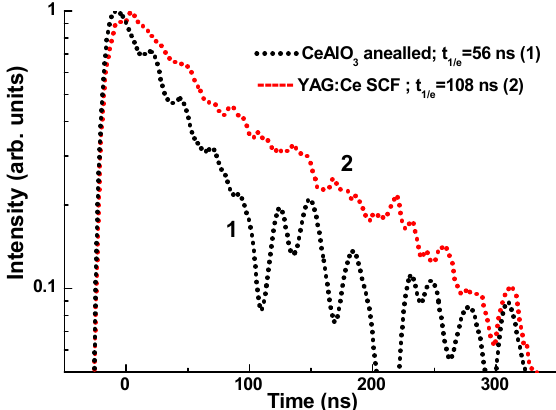
Figure 11. Normalized scintillation decay curves of annealed CeAlO 3 crystals under α -particle excitation of 239 Pu sources in comparison with a YAG:Ce SCF standard sample (2).